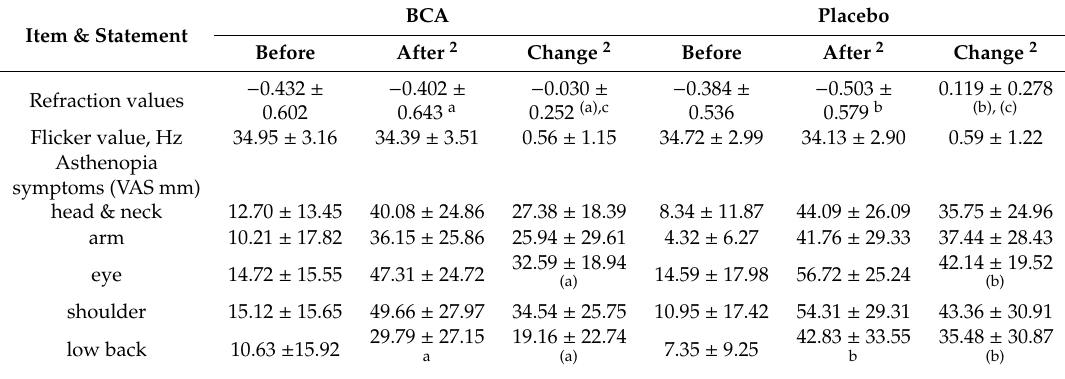
Table 6. Refraction values in dominant eye, flicker values, assessment of subjective asthenopia and changes in transient refractive alteration measured before and after a visual task in subjects orally administered BCA or placebo 1